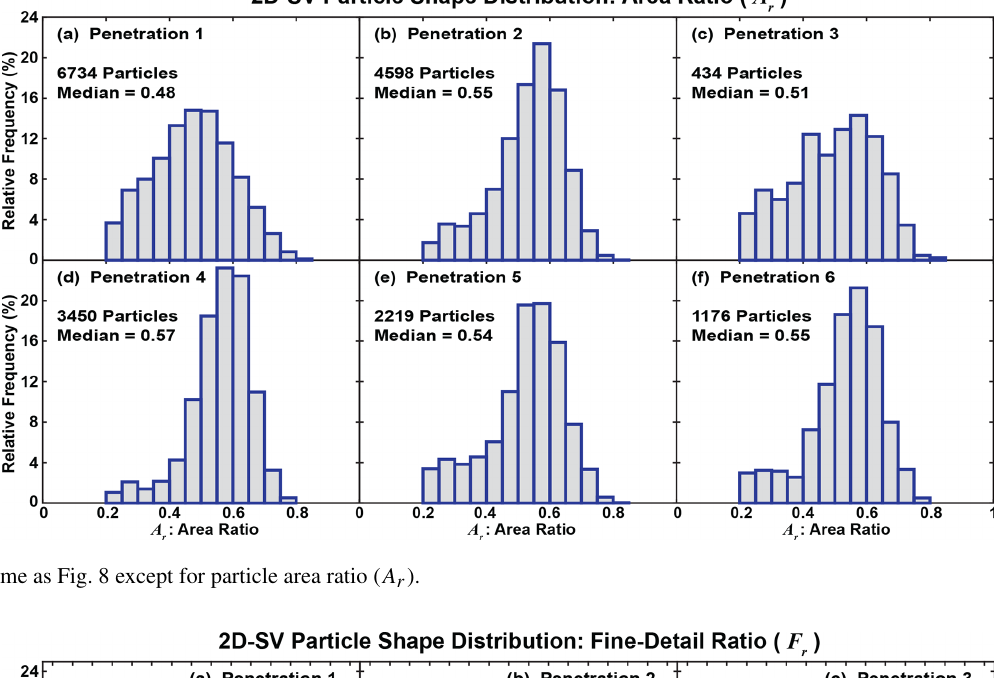
Figure 10. Same as Fig. 8 except for particle area ratio ( A r ).